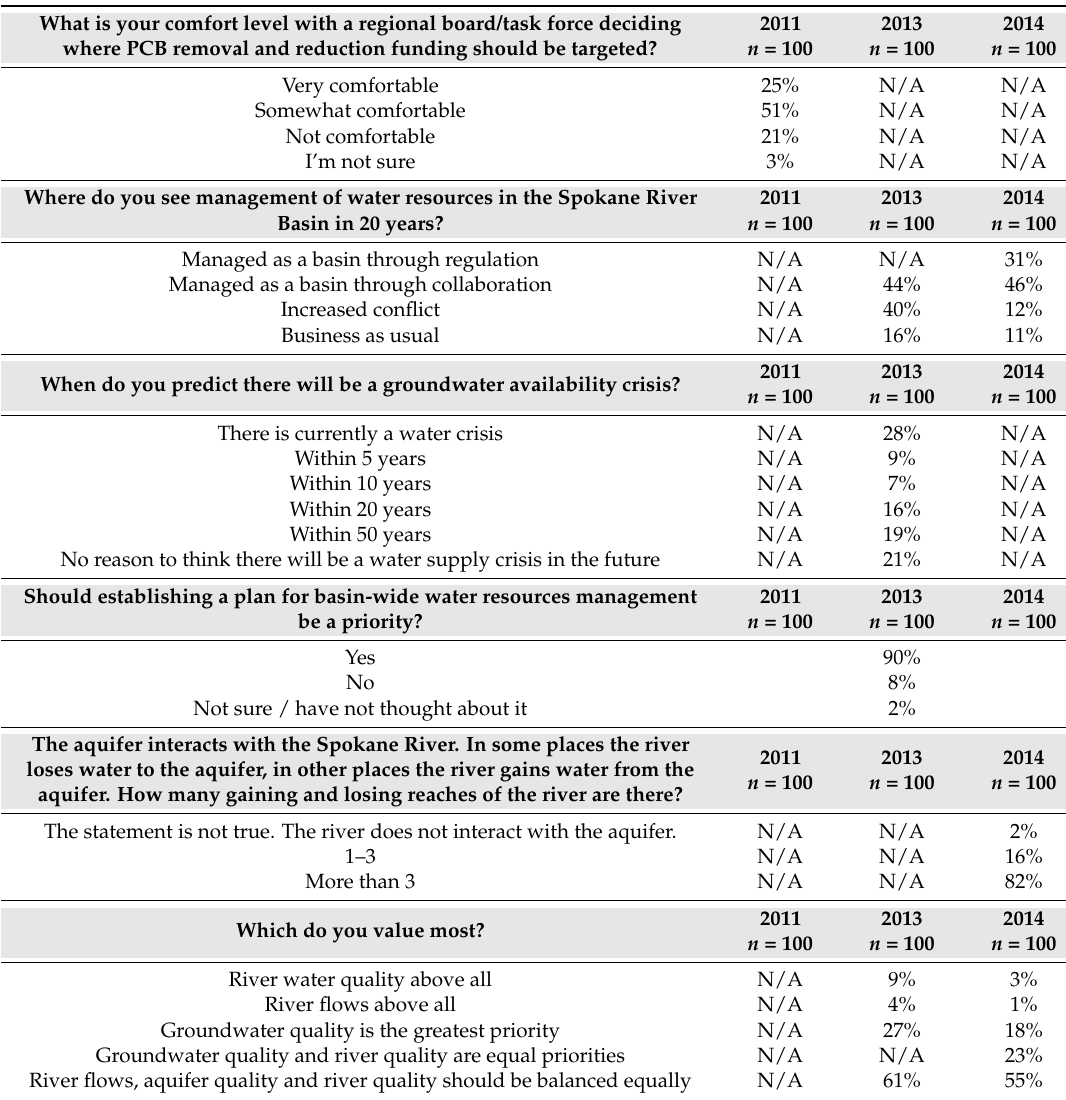
Table 5. Partial list of responses to clicker questions presented to participants at the Spokane River Forum in 2011, 2013 and 2014 (for additional questions please contact